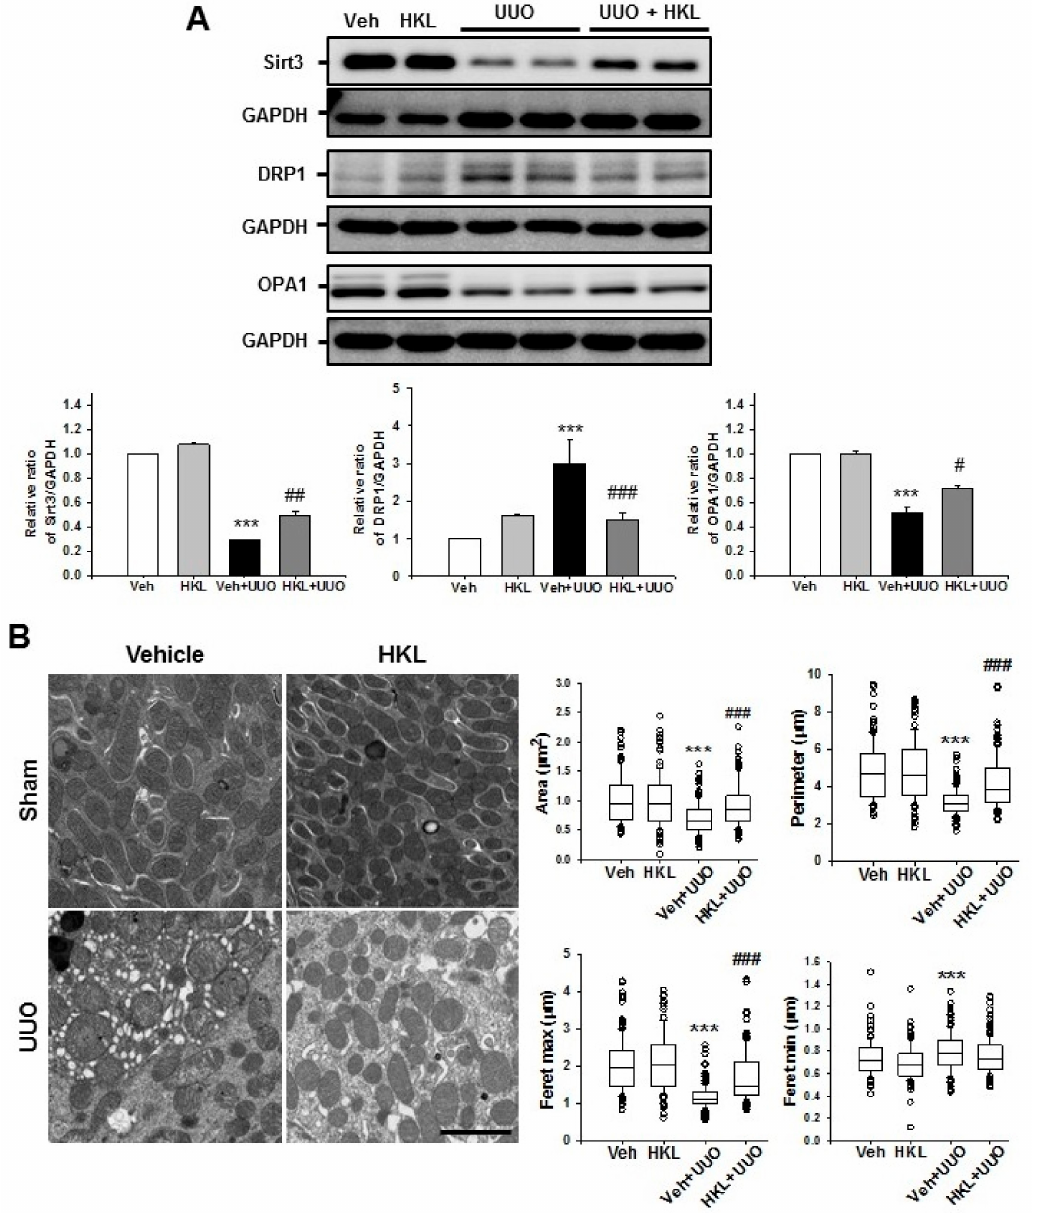
Figure 5. E ff ect of honokiol on unilateral ureteral obstruction (UUO)-induced Sirtuin 3 (SIRT3) expression and mitochondrial dynamics. ( A ) Representative Western blot analysis of